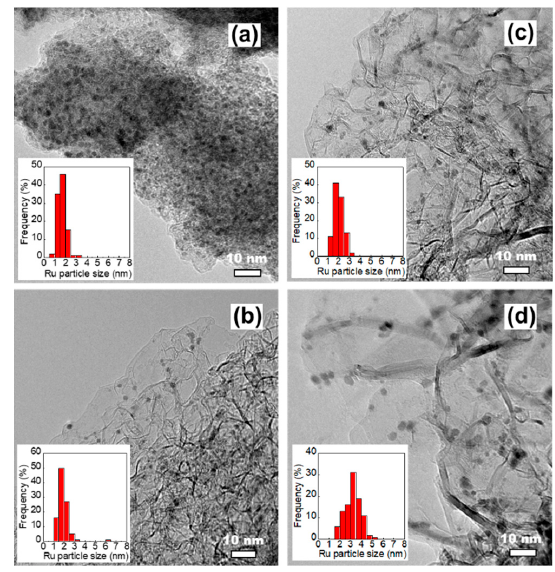
Figure 3 . HRTEM images and Ru particle size distributions of freshly prepared catalysts. ( a ) 2.5Cs- 10Ru/AC, ( b ) 2.5Cs-10Ru/MPC-15, ( c ) 2.5Cs-10Ru/MPC-18 and ( d )